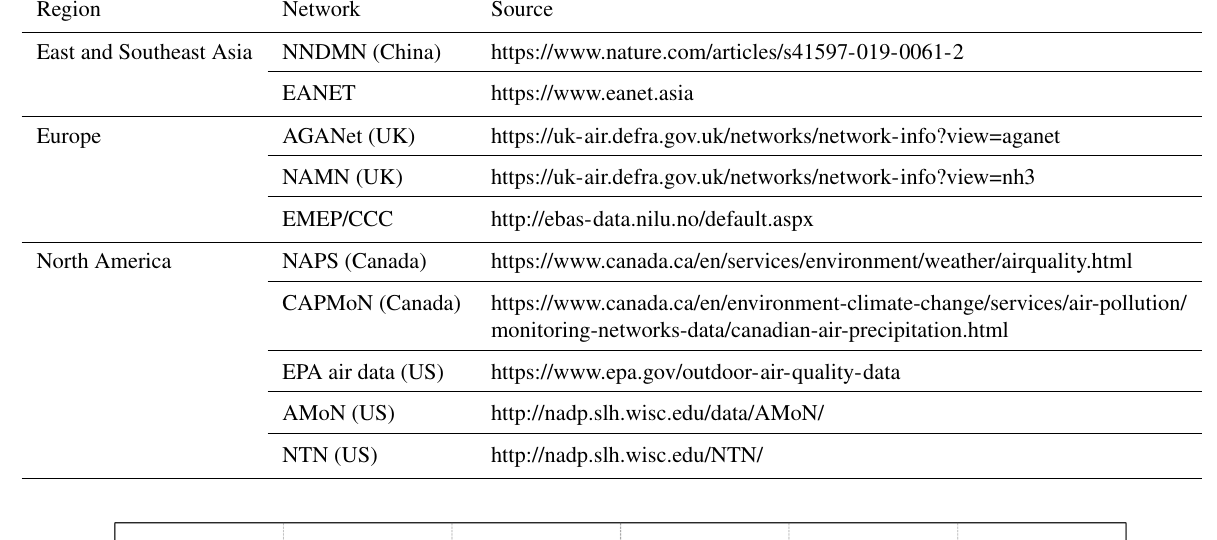
Table 1. Summary of surface monitoring networks used in the model–measurement comparisons. The last access date for all URLs cited in this table is 20 May 2021.